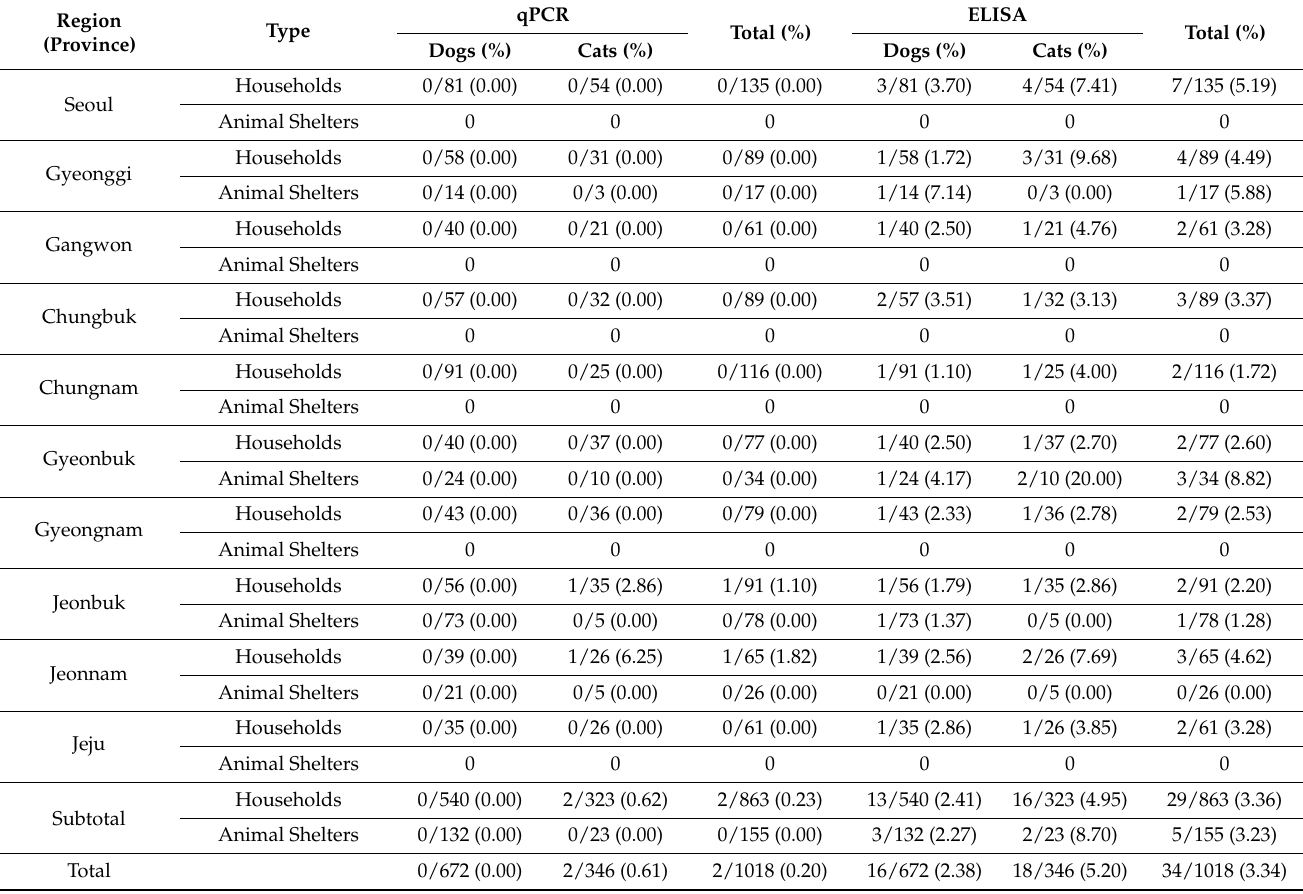
Table 1. Prevalence of SARS-CoV-2 in dogs and cats by regions in Korea.